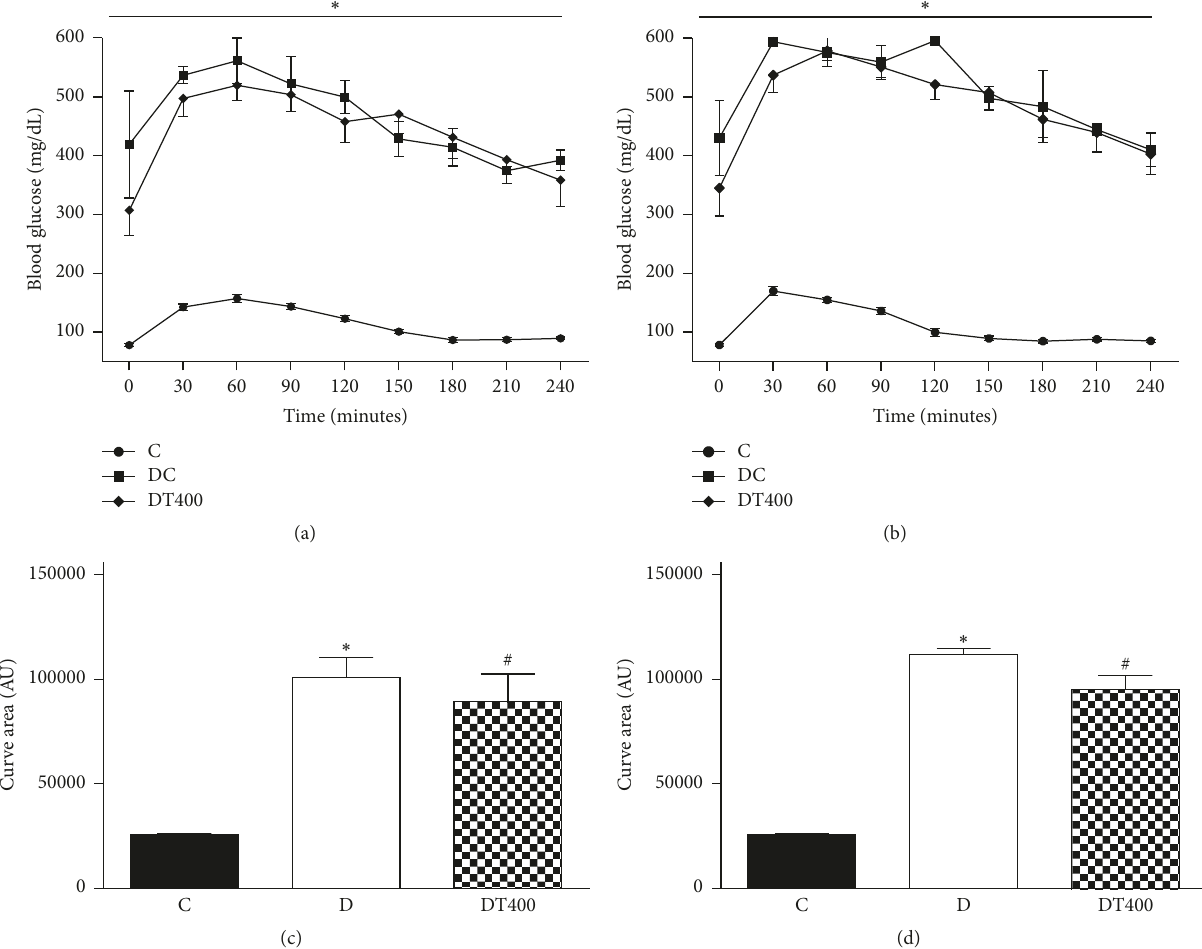
Figure 3: Effect of the EEMn on oral glucose at 10th (a) and 15th (b) day of experiment. C, nondiabetic control; DC, diabetic control; DT400, diabetic rats treated with 400 mg/Kg of EEMn. Area under curve (AUC) was calculated to determine glucose tolerance at 10th (c) and 15th (d) of treatments. Each point represents the means ± SEM of 7-8 animals. ∗ 𝑃 < 0.05 versus C; # 𝑃 < 0.05 versus